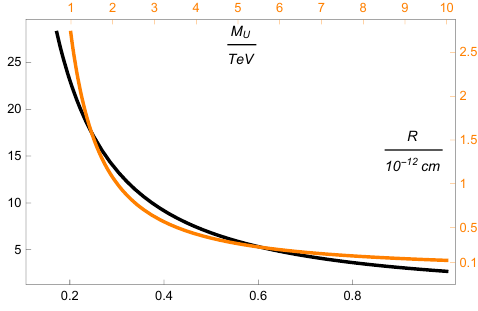
Figure 1. Compactification radius R vs. quantum gravity scale M U in the case of six large extra dimensions. The black and orange plots denote the cases in which M U takes values below and above 1 TeV,